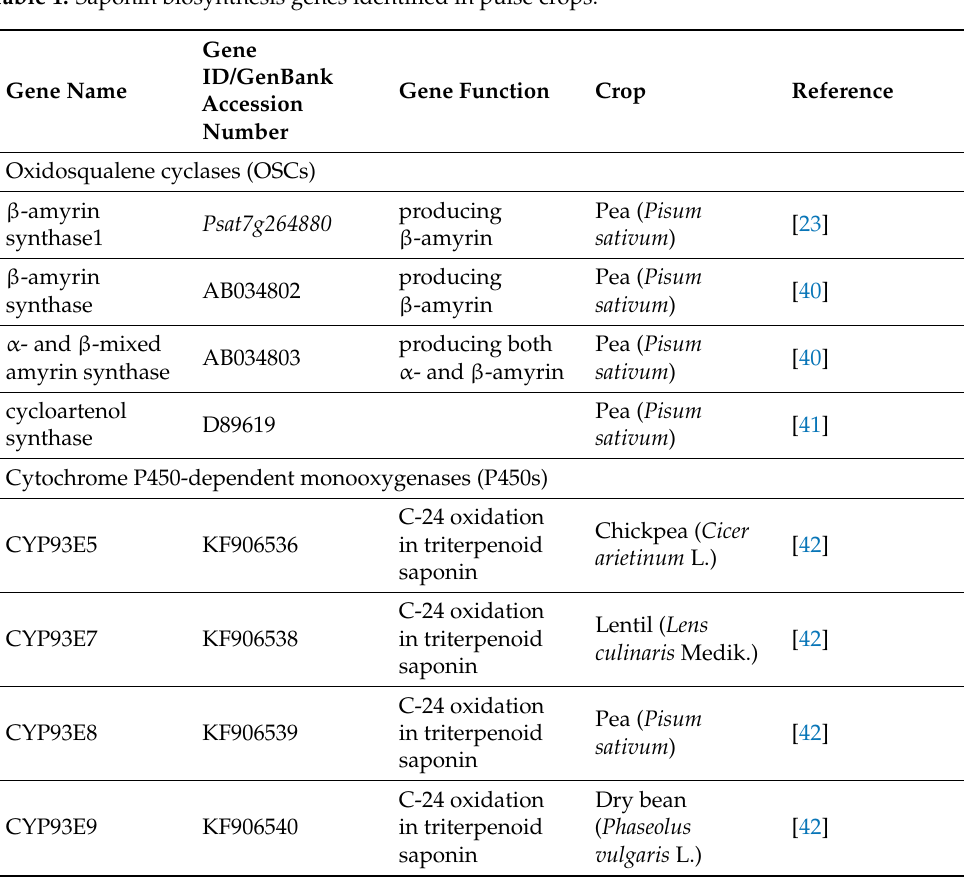
Table 1. Saponin biosynthesis genes identified in pulse